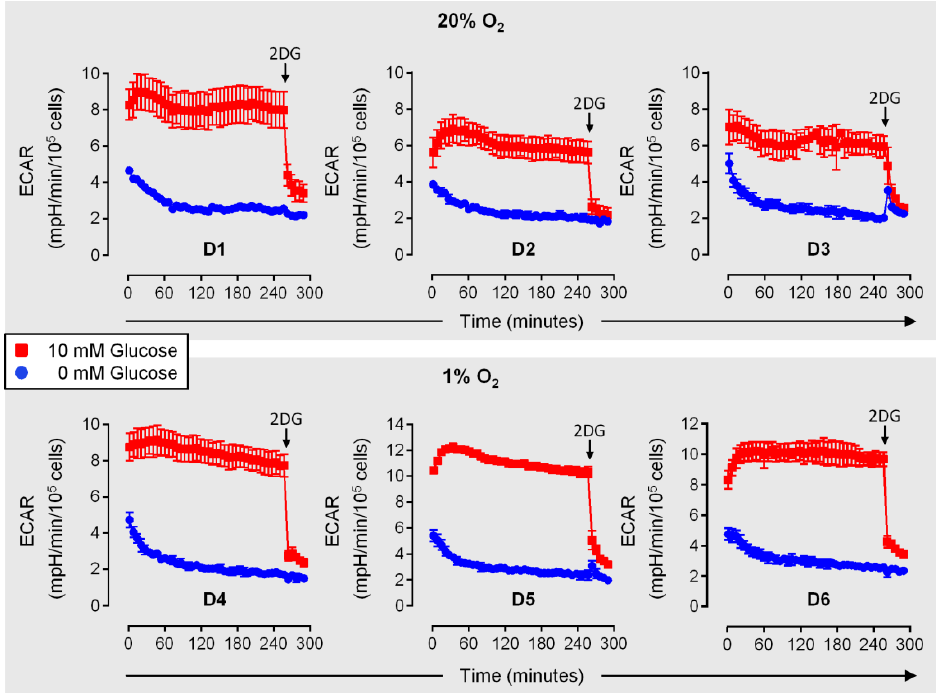
Figure 6. Glycolysis in human NK cells rapidly declines upon glucose deprivation. NK cells were isolated from 6 donors and cultured under normoxia (20% O 2 , D1–D3) or hypoxia (1% O 2 , D4–D6). At 16 h, IL-15 was added for another 6 h. At 22 h cells were transferred into glucose-containing (red) or glucose-deficient (blue) medium in the continued presence of IL-15 plus IL-12/IL-18 and were immediately subjected to extracellular acidification rate (ECAR) measurements. For D1–D3, determinations were done under normoxia and for D4–D6 under hypoxia. Toward the end of the experiment, glycolysis was inhibited by adding 50 mM 2-deoxyglucose (2DG) to all samples (arrow). ECAR traces are based on averaged technical triplicates ± SEM.